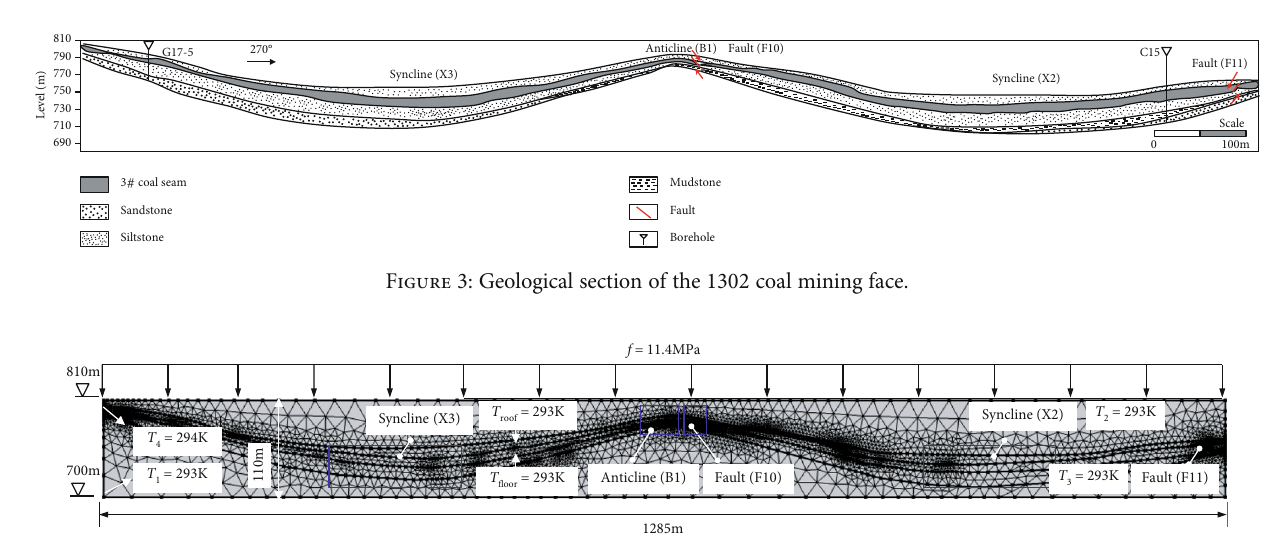
Figure 4: Numerical model and boundary conditions of the THM model in the 1302 coal mining